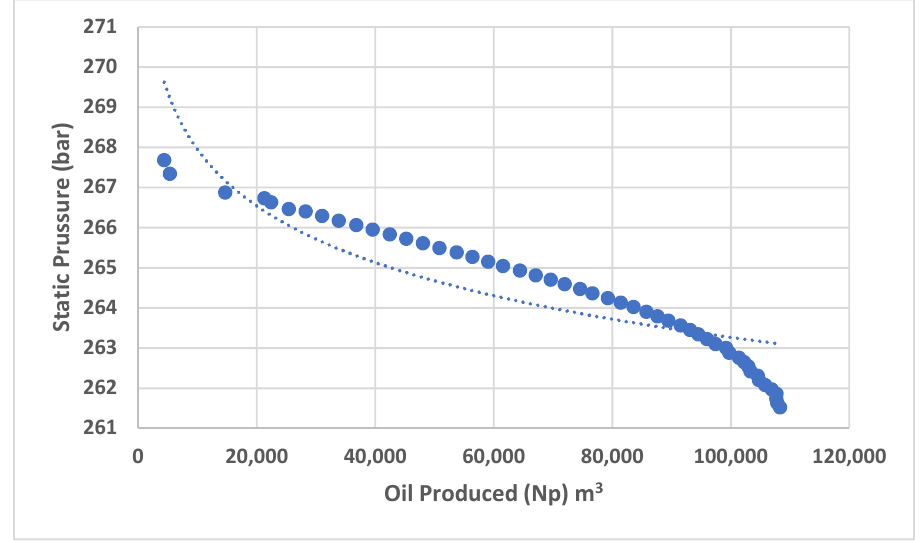
Figure 6. Pressure versus oil produced.